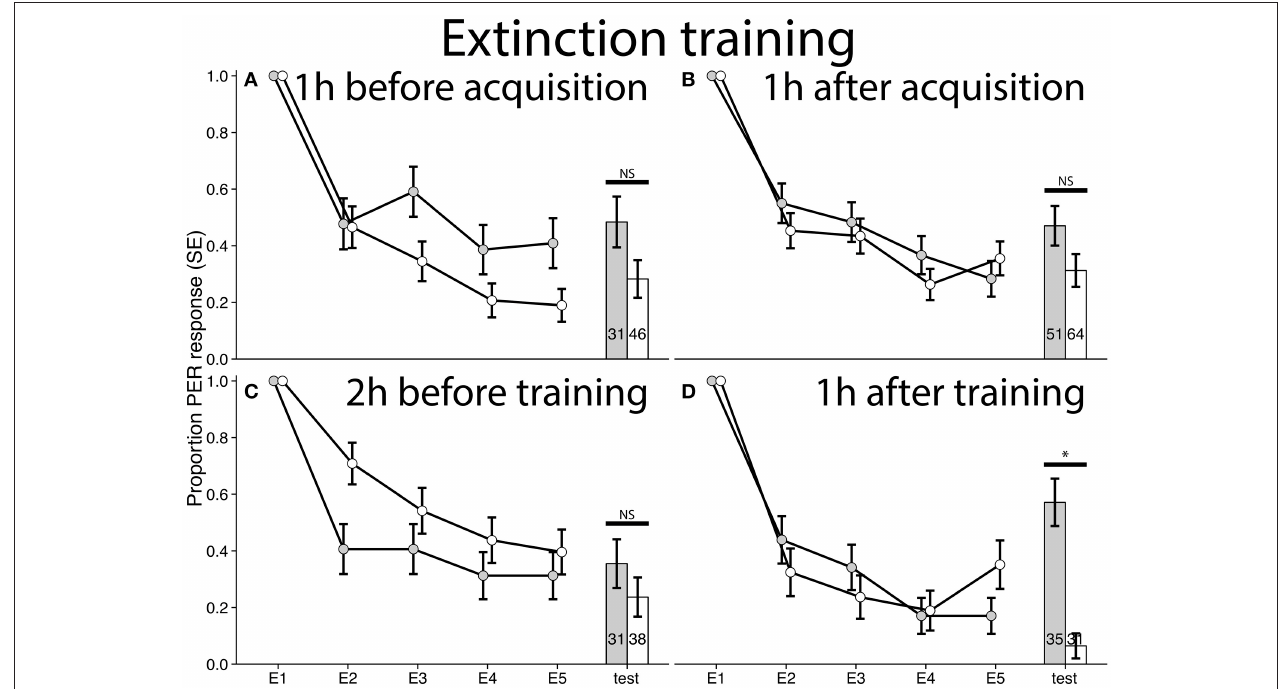
FIGURE 3 | Extinction curves and test results for bees trained in a differential conditioning PER training paradigm. E1–E5 refers to each odor exposure during extinction. Gray bars/dots represent bees treated with cocaine and controls are in white. (A) Experiment 1: Bees treated with cocaine 1h before acquisition training ( χ 2 = 2.4304, p = 0.119, n = 77). (B) Experiment 2: Bees treated 1h after acquisition training ( χ 2 = 2.3709, p = 0.1236, n = 115). (C) Experiment 3: Bees treated 2h before extinction training ( χ 2 = 0.6527, p = 0.4192, n = 69). (D) Experiment 4: Bees treated 1h after extinction training ( χ 2 = 16.7965, p < 0.00001, n = 66, φ = 0.5044). Note that for extinction memory, lack of PER expression signifies successful memory formation. *Denotes statistically significant differences.